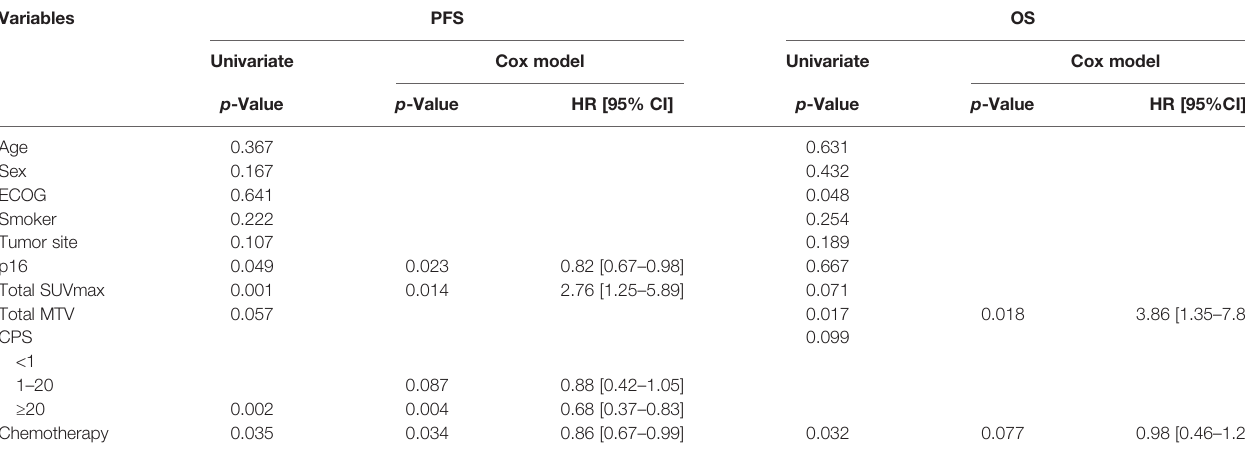
TABLE 5 | Univariate analysis and Cox model for progression-free survival (PFS) and overall survival (OS). Variables